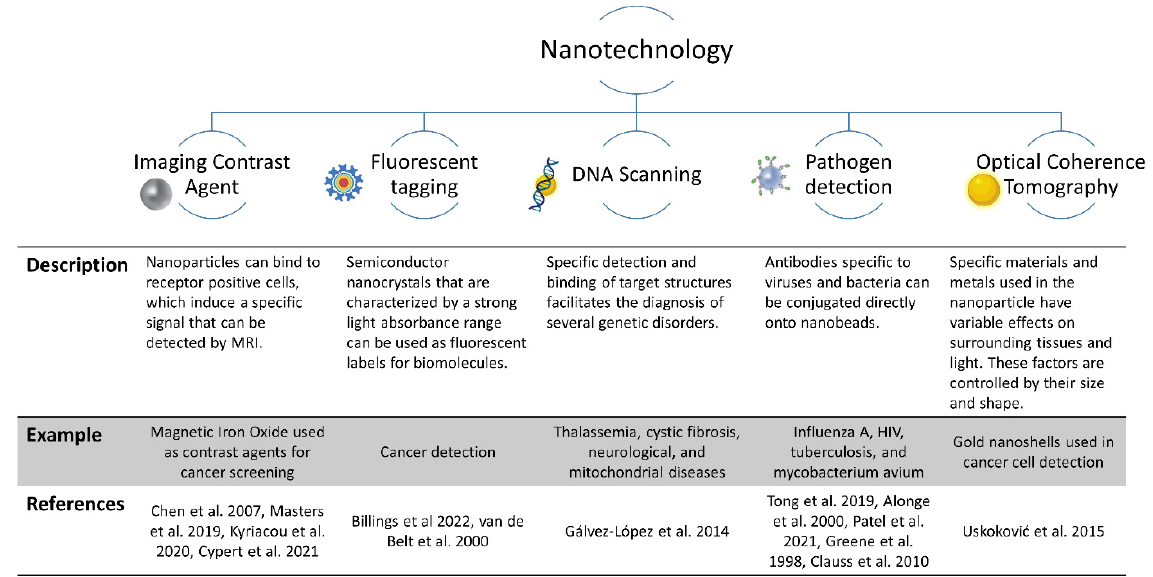
Figure 5. Summary of different types nanotechnology that can be used for disease diagnosis